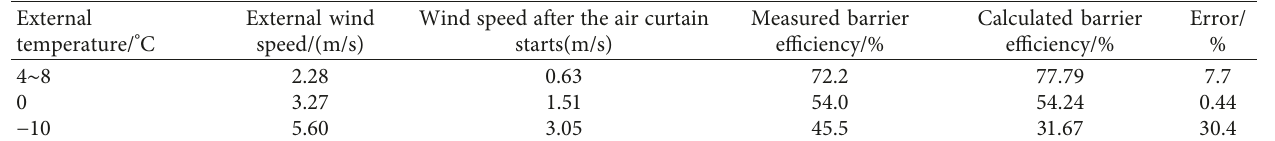
Table 5: Measured data and calculated values of air curtain on main